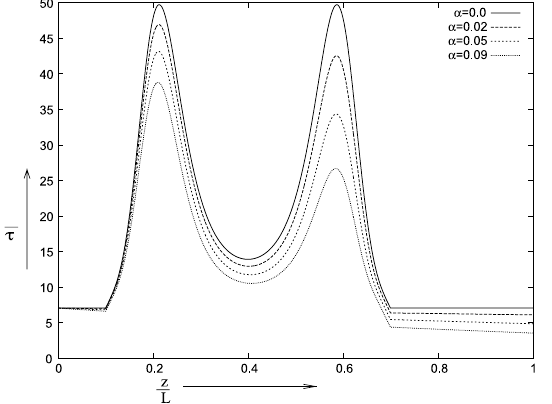
Fig. 14. Distribution of wall shear stress ¯ τ along with z for different values of α when H = 0 . 2, β = 2 . 5, M = 2 . 5 and k = 0 .